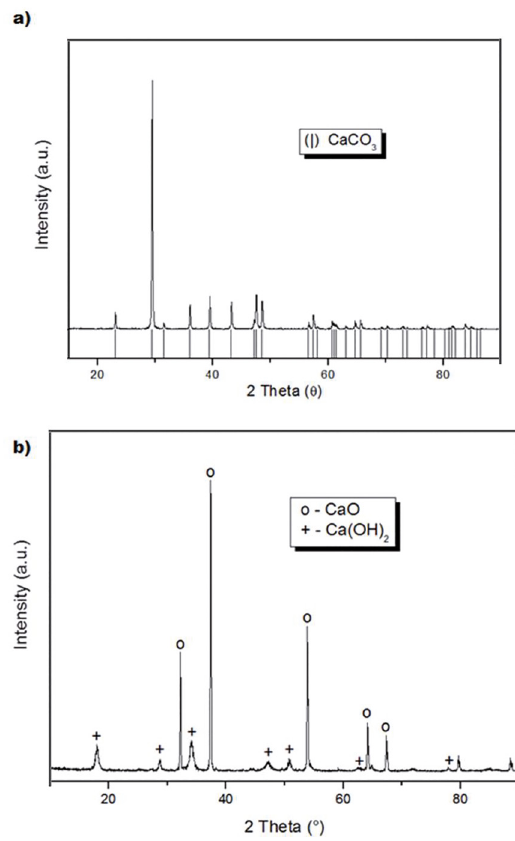
Figure 1: XRD patterns: (a) Milled ostrich eggshell and (b) calcined